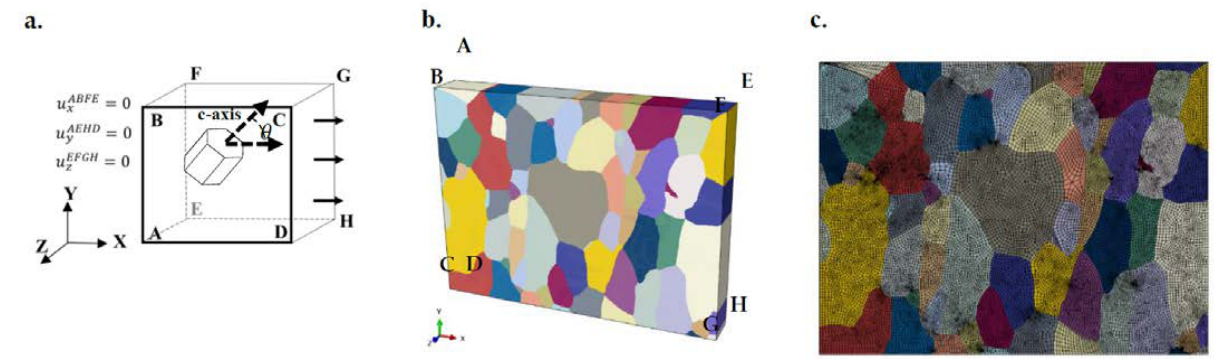
Figure 2. ( a ) Applied boundary conditions for the single crystal model. ( b ) The EBSD-measured microstructure imported into the finite element solver with the meshed map shown in ( c ).